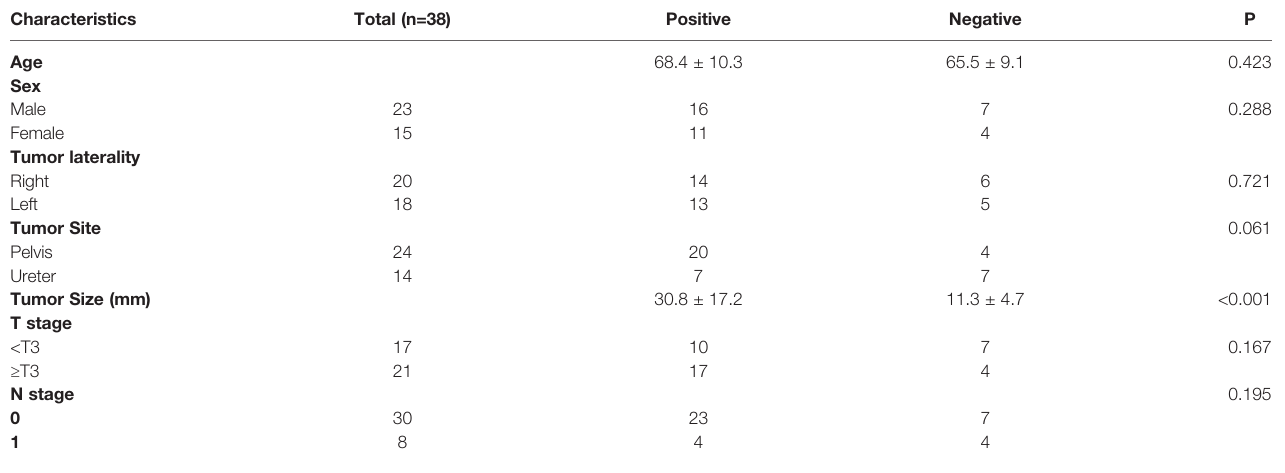
TABLE 5 | Patient characteristics according to positive and negative PET group (n=38).